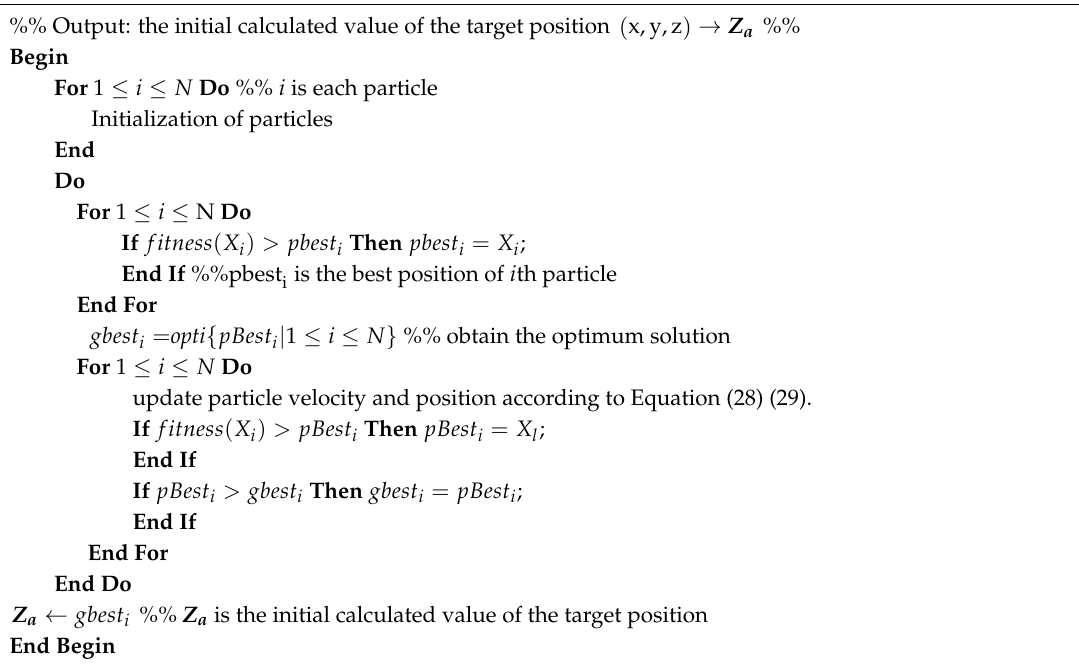
Figure 1. The framework of the PSO-IMChan based on the positioning system. Algorithm 1. The Improved PSO Positioning Method